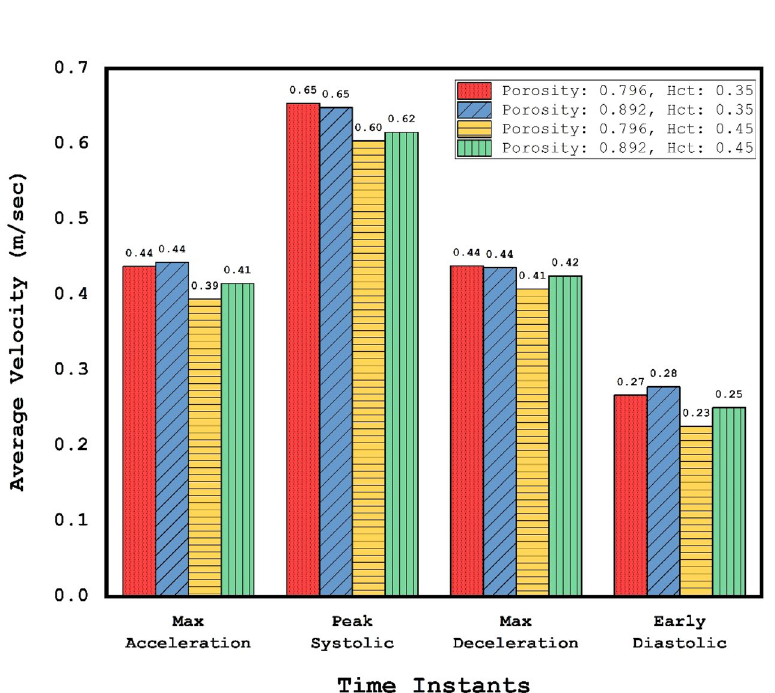
Figure 15. Comparison of the average velocity at inlet of sac for different HCTs and Coiling